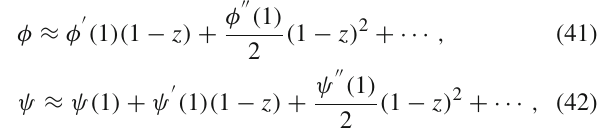
Table1 Comparisonofanalyticalandnumericalvaluesof ζ = T c /ρ 1 / 3 for α = 0 . 0001